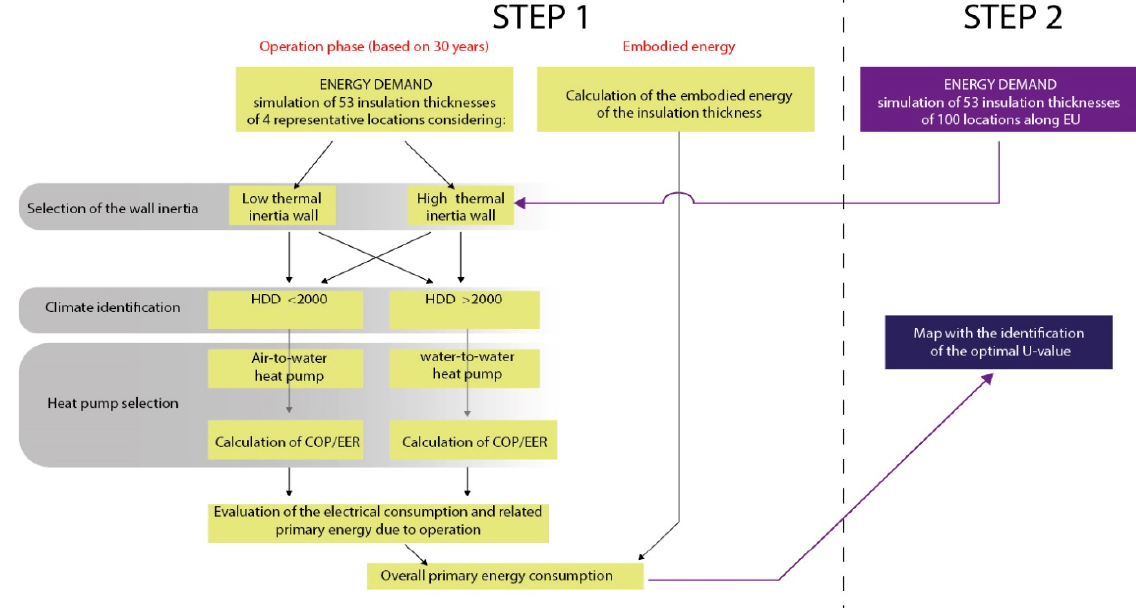
Figure 2. Research methodology workflow.